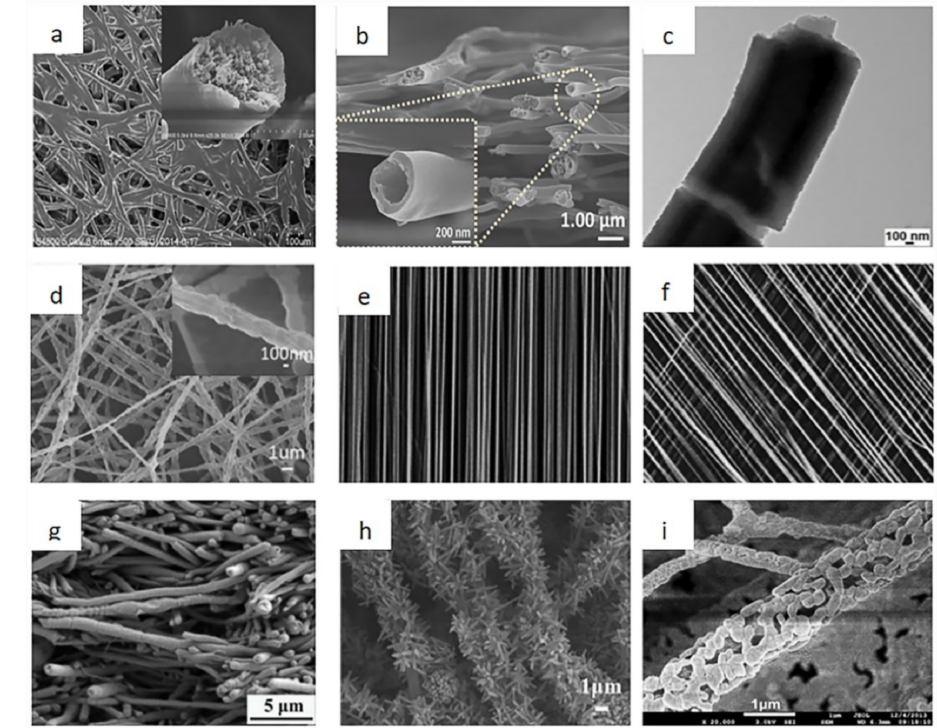
Figure 7. The different morphologies of the electrospun nanofibers. ( a ) Cobweb nanofiber [18]; ( b ) hollow nanofiber [19]; ( c ) core-shell nanofibers [20]; ( d ) randomly distributed nanofibers [21]; ( e ) aligned nanofibers [22]; ( f ) patterned nanofibers [23]; ( g ) composite nanofiber [24]; ( h ) pine needle nanofibers [25]; ( i ) hollowed-out nanofibers